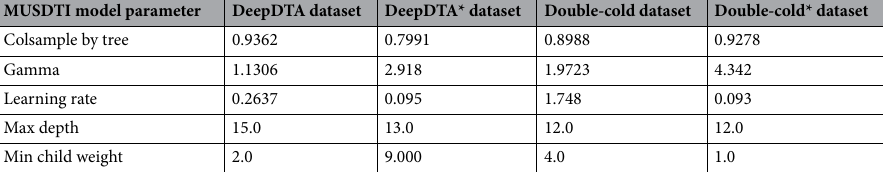
Table 3. MUSDTI hyperparameter values. The * designation denotes the model parameters used for the ensembled MUSDTI* model prior to the cascaded application of RP.